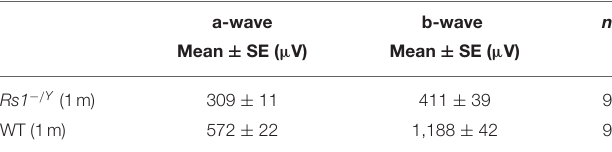
TABLE 1 | a-Wave and the b-wave amplitudes (0 log cd.s/m 2